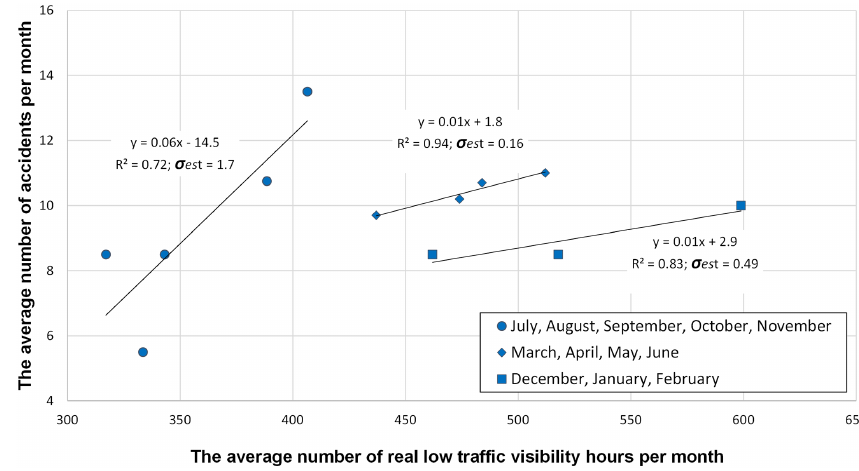
Figure 4. The regression lines corresponding to the three seasonal variations